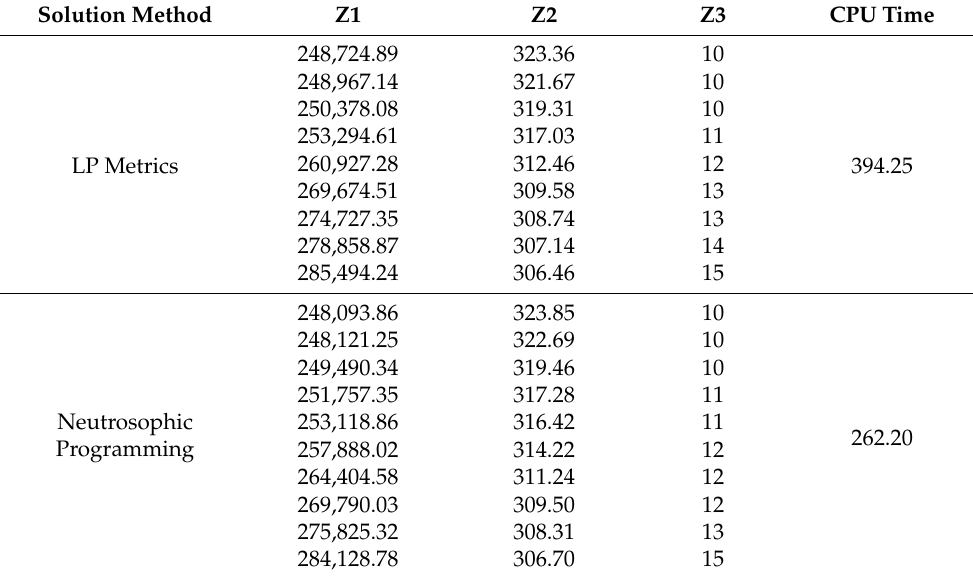
Table 5. Efficient solutions obtained from problem-solving. Solution